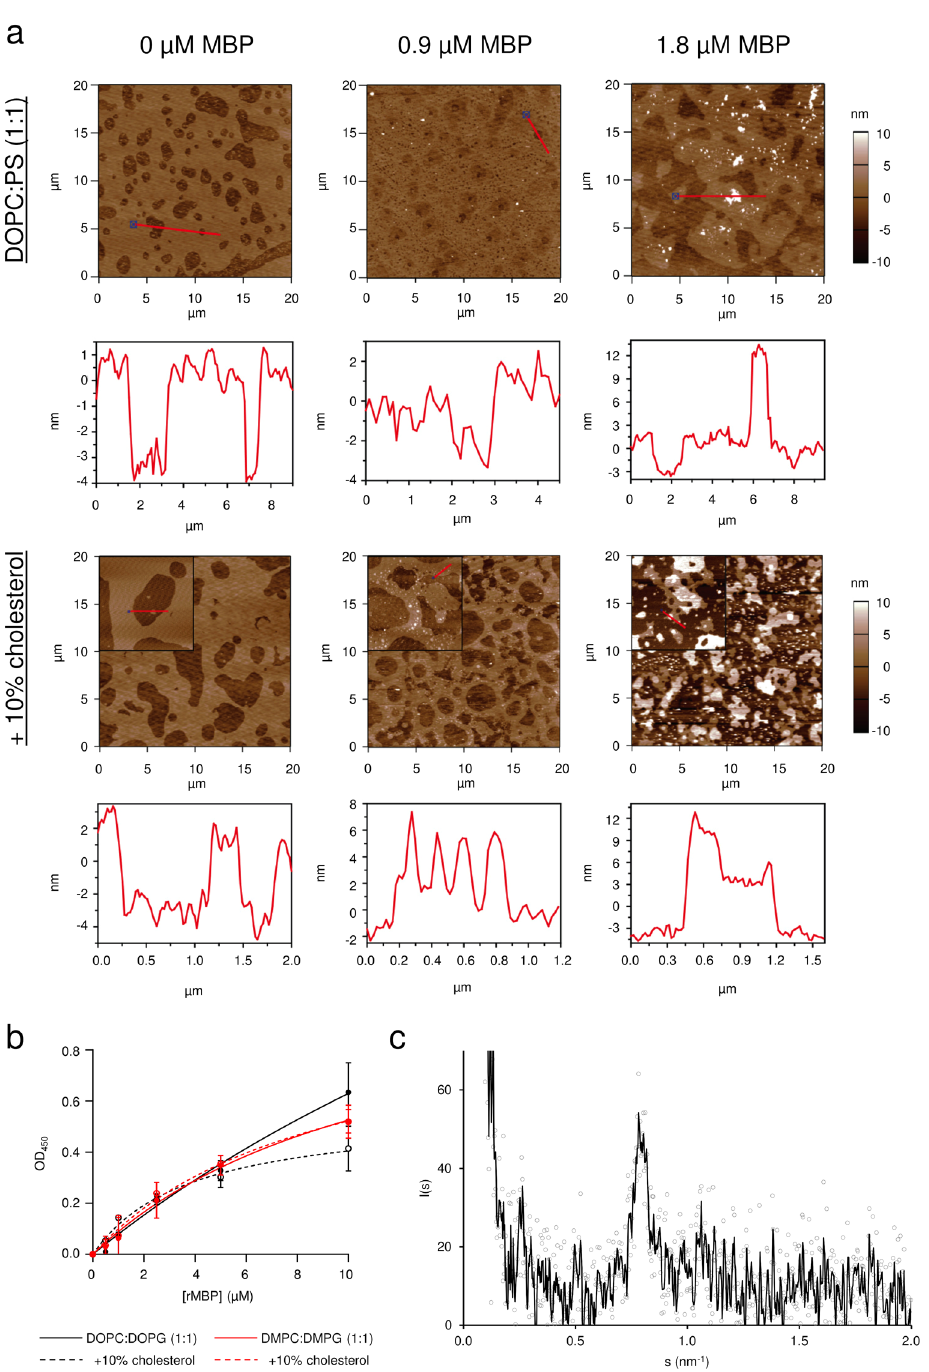
Figure 3. Membrane-stacking properties of rMBP. ( a ) In AFM, rMBP binds to supported DOPC:DOPS (1:1) lipid bilayers and spontaneously produces bilayer stacks after reaching sufficient protein concentration. The quality and area of the observed membrane stacks are influenced by the presence of cholesterol, without a significant effect on the measured stack thickness. Red lines denote the walk sections in the images, for which height diagrams have been plotted below. The walks from the cholesterol images have been extracted from 5- µ m image insets for better quality. A single bilayer and stack are ~4 and 12 nm in height, respectively. ( b ) Turbidity measurements show that the tendency of rMBP to aggregate vesicles remains mostly unaffected by the lipid tail saturation degree or the presence of cholesterol. Error bars represent standard deviations. ( c ) rMBP mixed with DMPC:DMPG (1:1) SUVs displays a Bragg peak in SAXD that corresponds to a mean repeat distance of 80 Å at 1:100 molar P/L. A running average (black line) has been added for clarity over the raw measurement data (grey